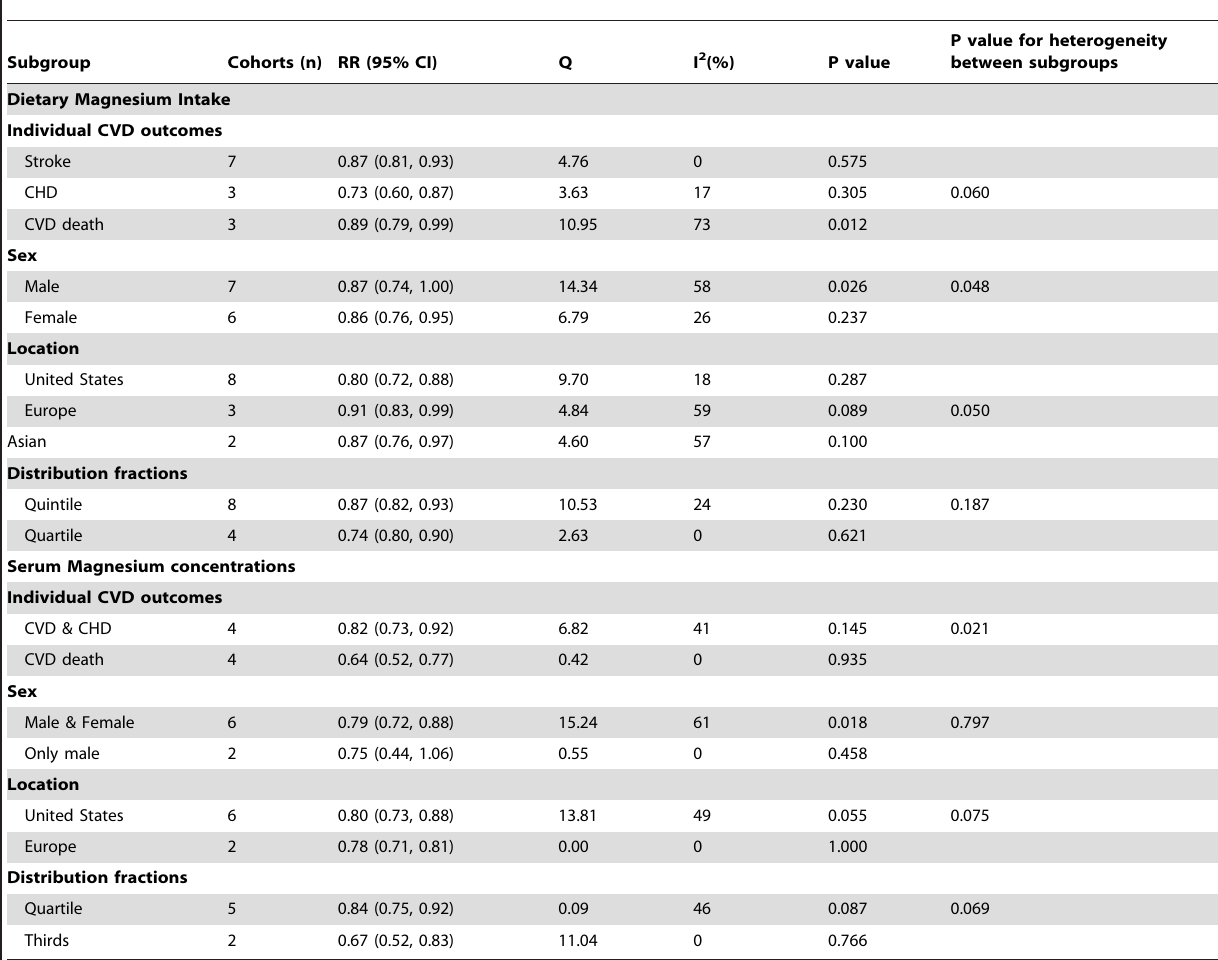
Table 4. Subgroup analysis to investigate differences between studies included in meta-analysis.